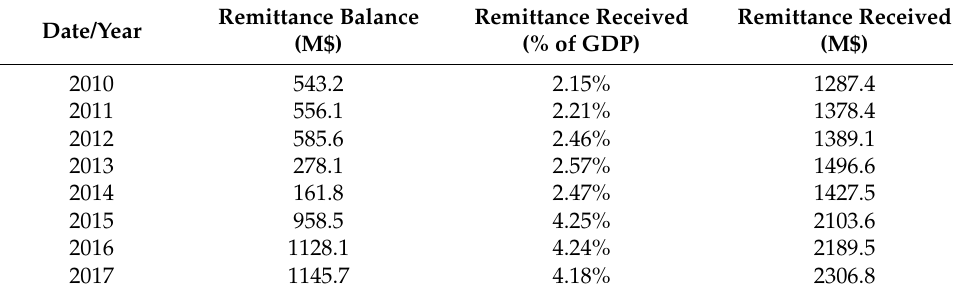
Table A1. Remittances received by Croatia (annual data).